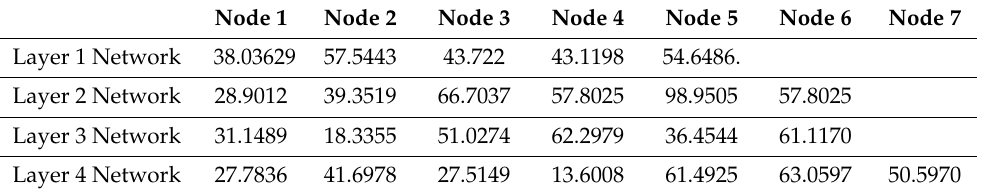
Table 7. Cost of adding a redundancy to a node.